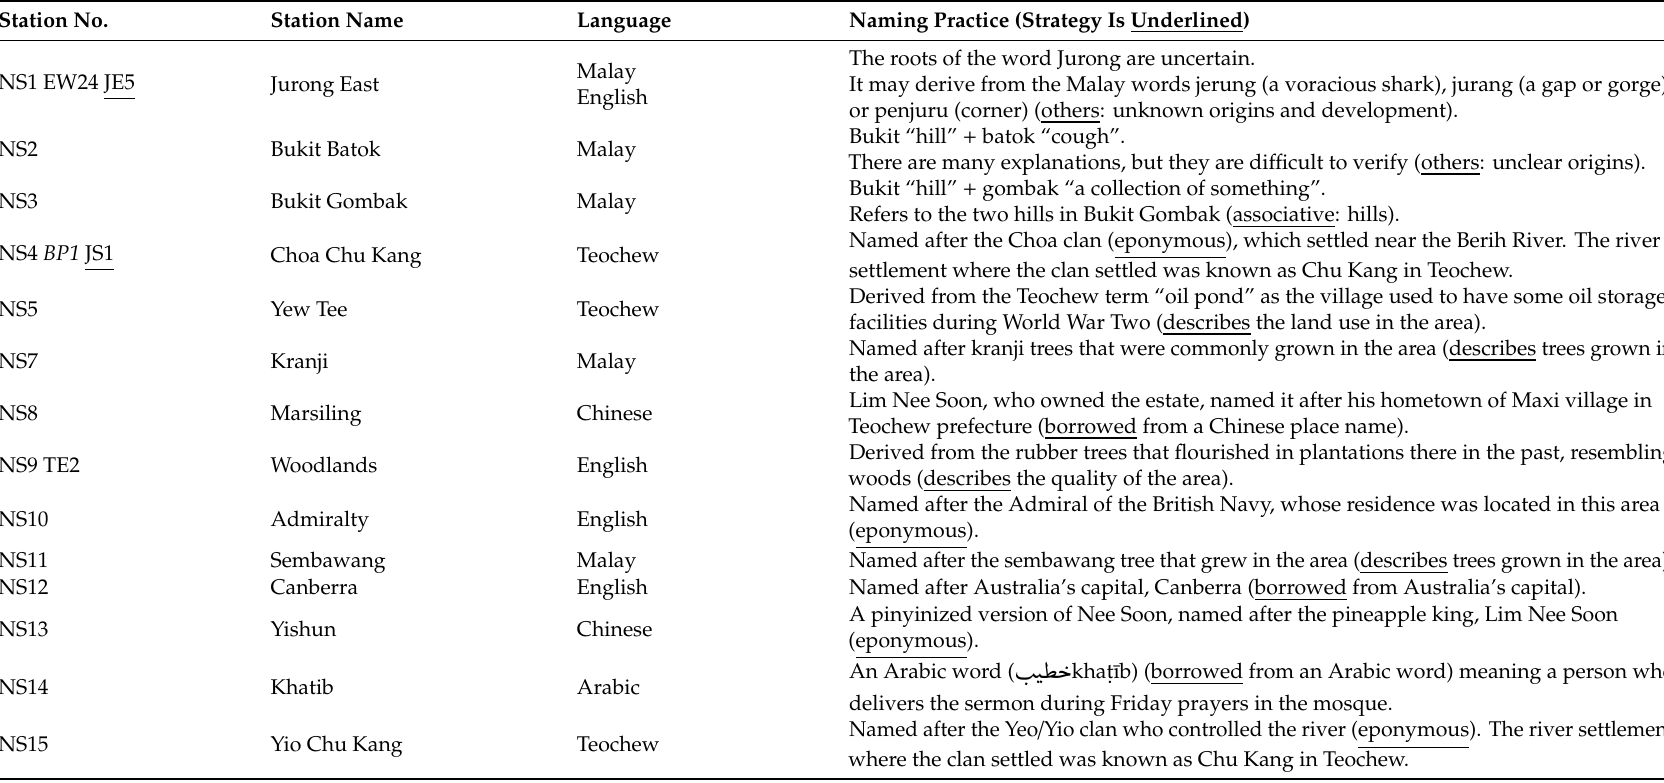
Table A1. Analysis of MRT Stations on the North South